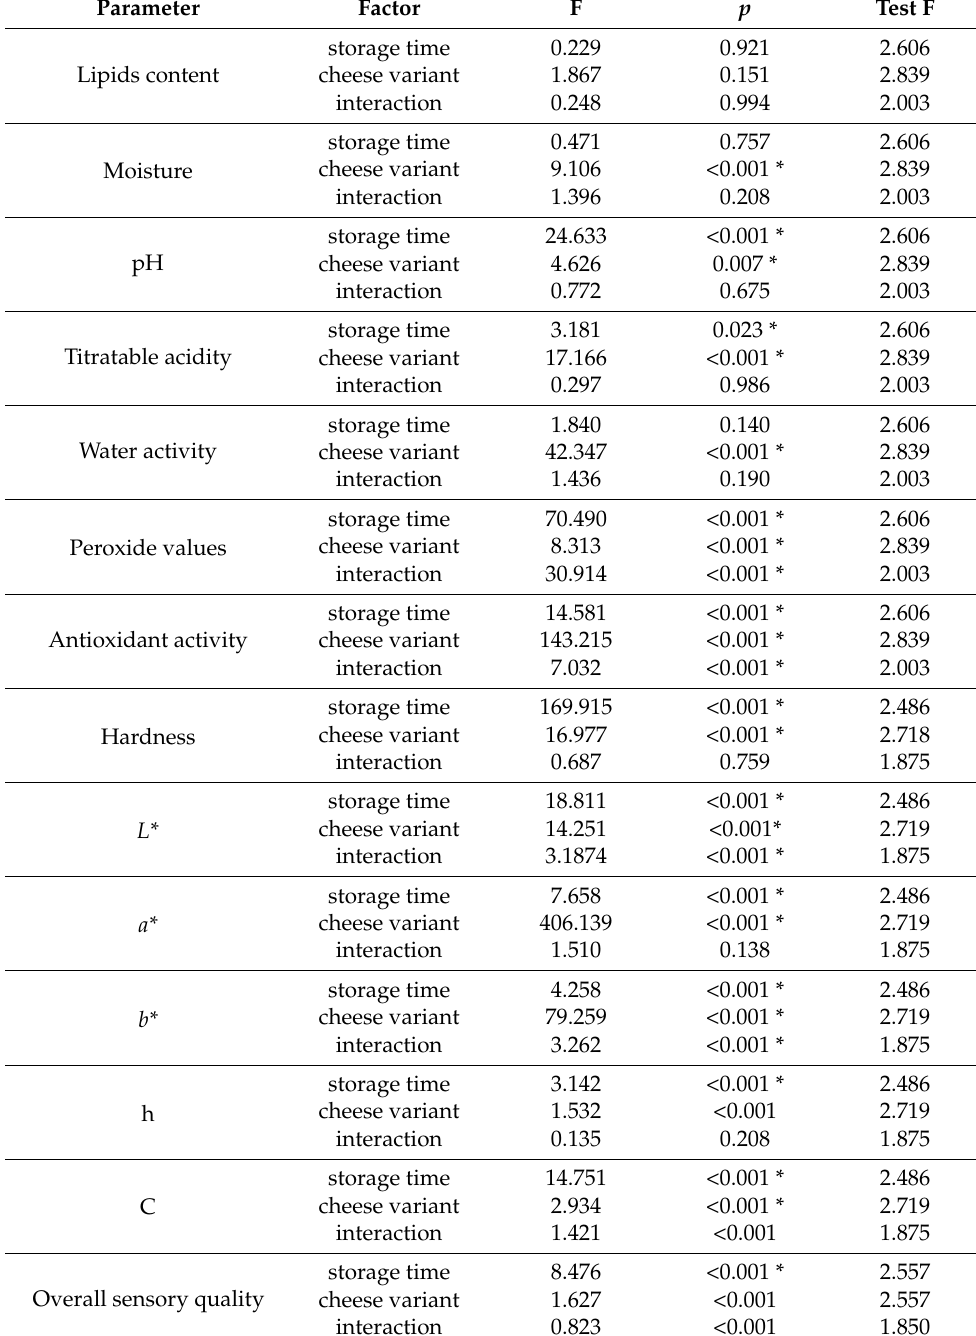
Table 1. Results of 2-way ANOVA of physicochemical properties and overall sensory quality of acid curd cheese (ACC). p value with * means that differences are statistically significant (F > Test